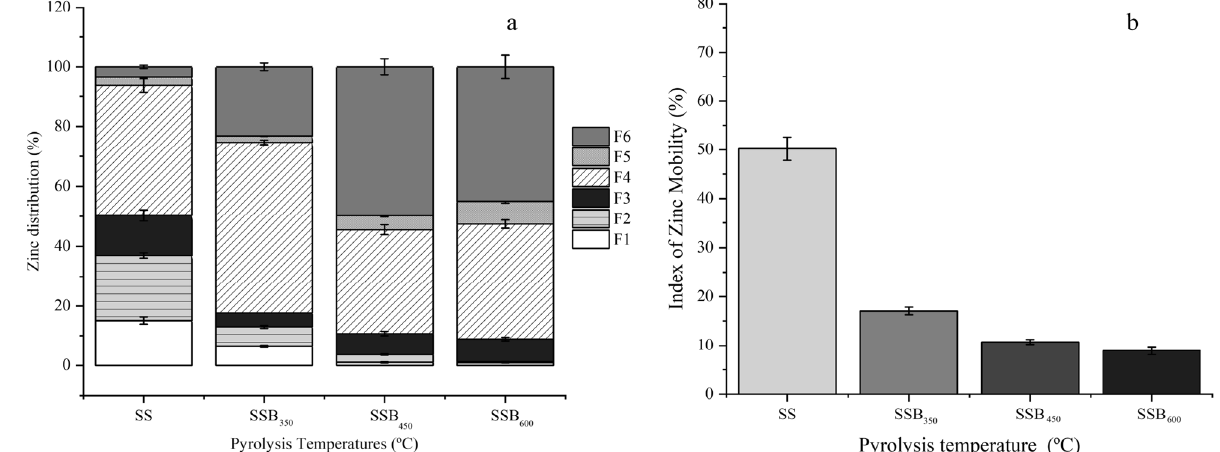
Figure 6. Zinc fraction distribution ( a ) and mobility index ( b ) of sewage sludge biochar produced at 350 (SSB 350 ), 450 (SSB 450 ) and 600 (SSB 600 ).